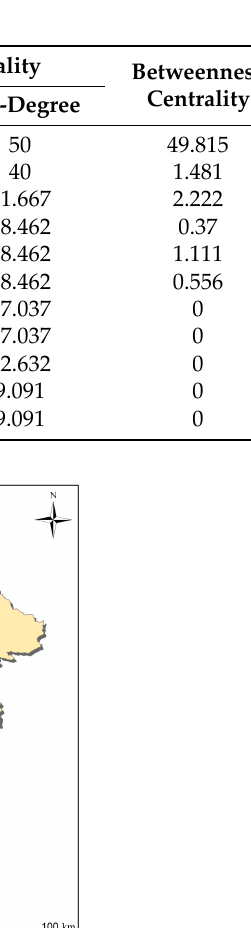
Table 2. Total traffic flow and centrality.